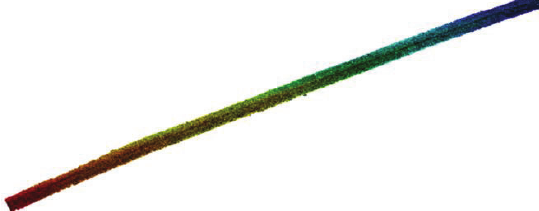
Figure 7. Perspective view of MLS data points of